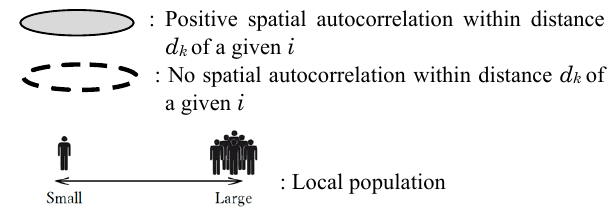
Figure 2 . Conceptual diagram with respect to the detection of the spatial features of local populations (Kumagai et al.